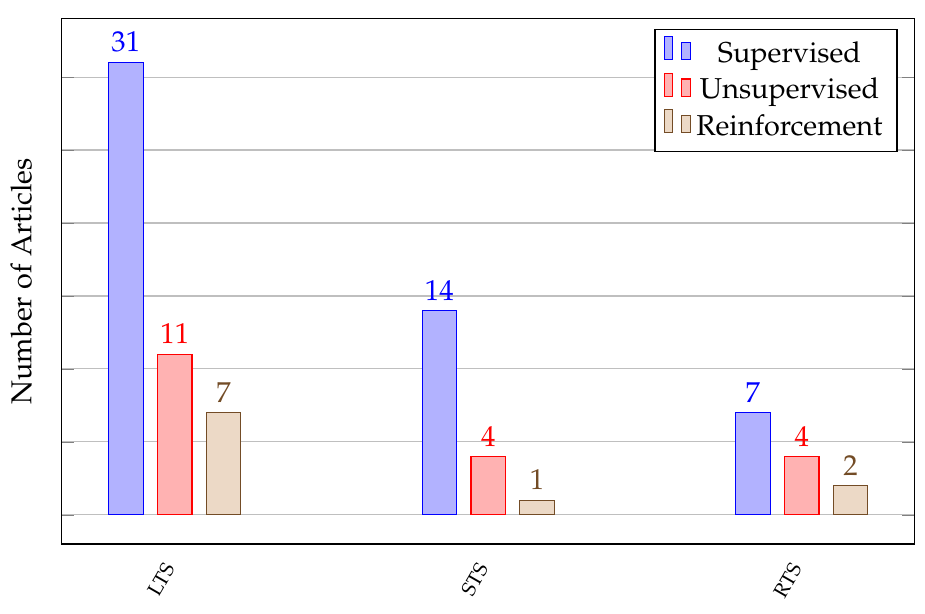
Figure 10. Machine Learning vs forecast